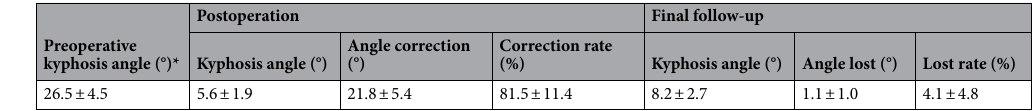
Table 1. Kyphosis correction and kyphosis lost in single posterior approach.